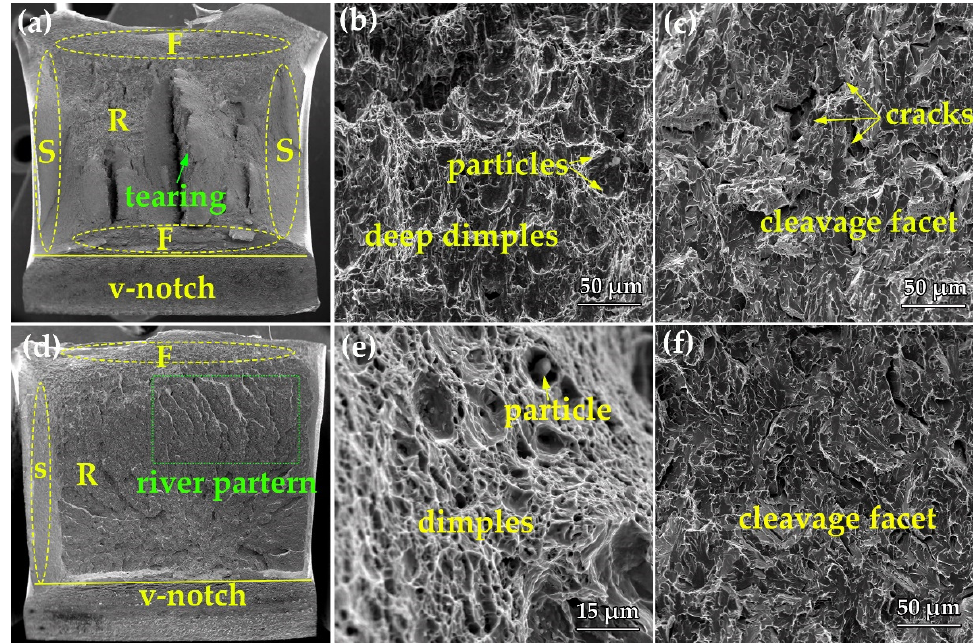
Figure 8. The impact fractography of the specimens obtained from the surface of steel A and B. ( a , d ) macrographs; ( b , e ) the fractography of shear lip zone; ( c , f ) the fractography of radial zone.